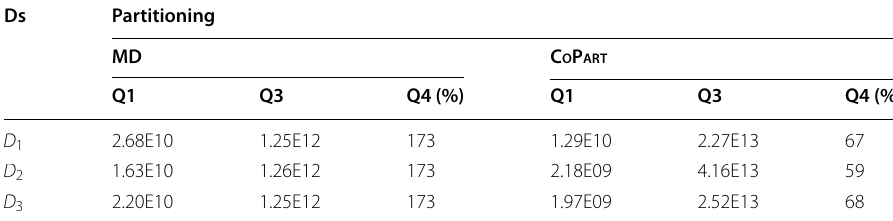
Table 3 Quality metrics for the various partitioning techniques